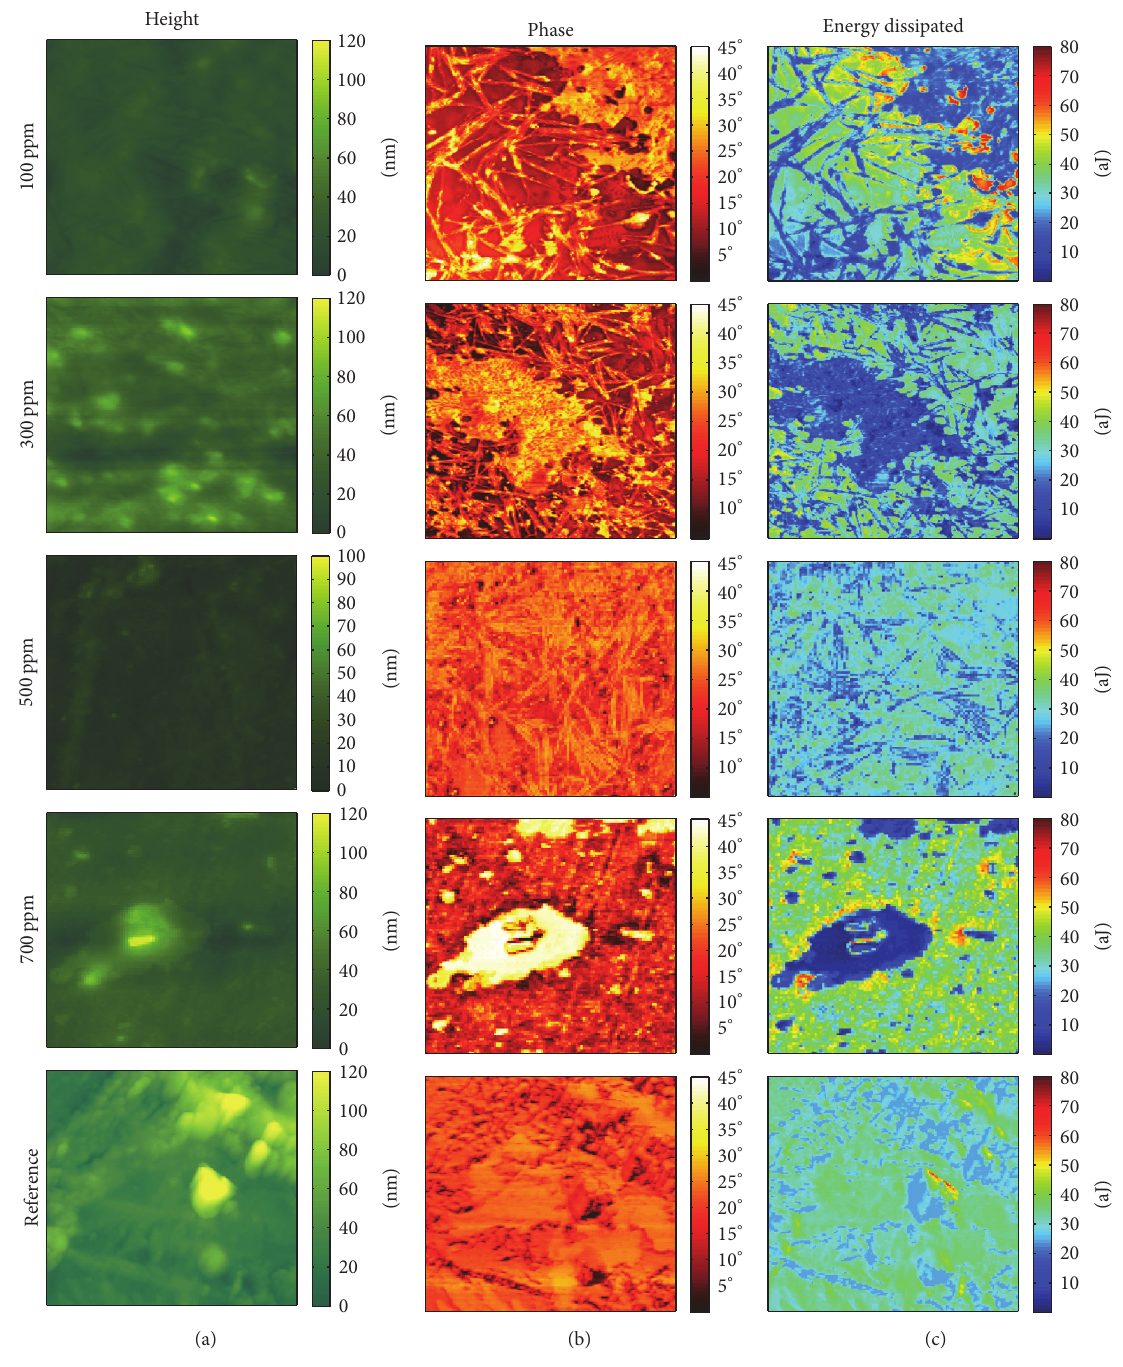
Figure 3: AFM height, phase contrast, and energy dissipation images of a PS matrix with different amounts of Ag/TiO 2 nanoparticles. Color contrast observed on the surfaces is related to the presence of Ag/TiO 2 nanoparticles on those regions. Some agglomerates are observed in the sample containing 700 ppm of Ag/TiO 2